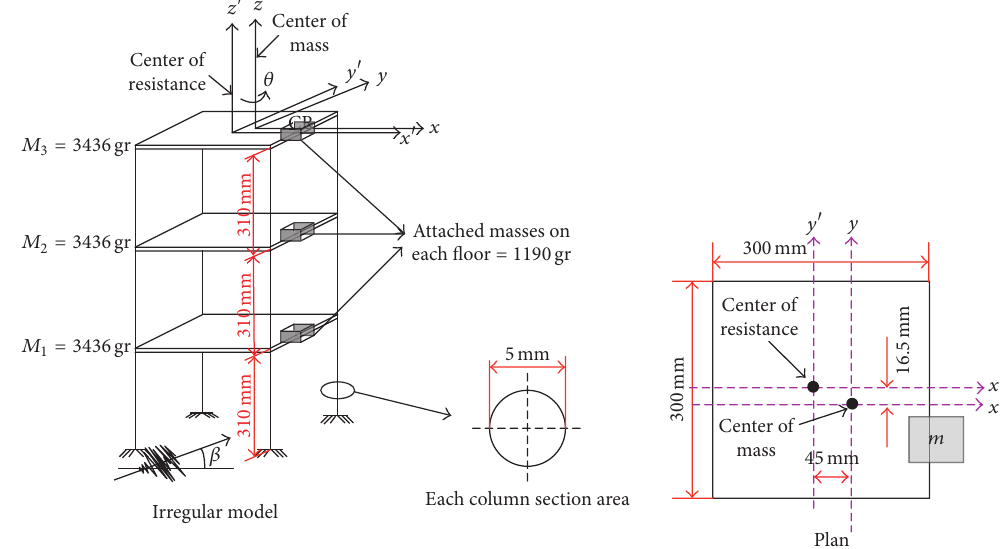
Figure 1: The mass and configuration details of the scaled irregular 3D three-story resisting steel frame building structure.